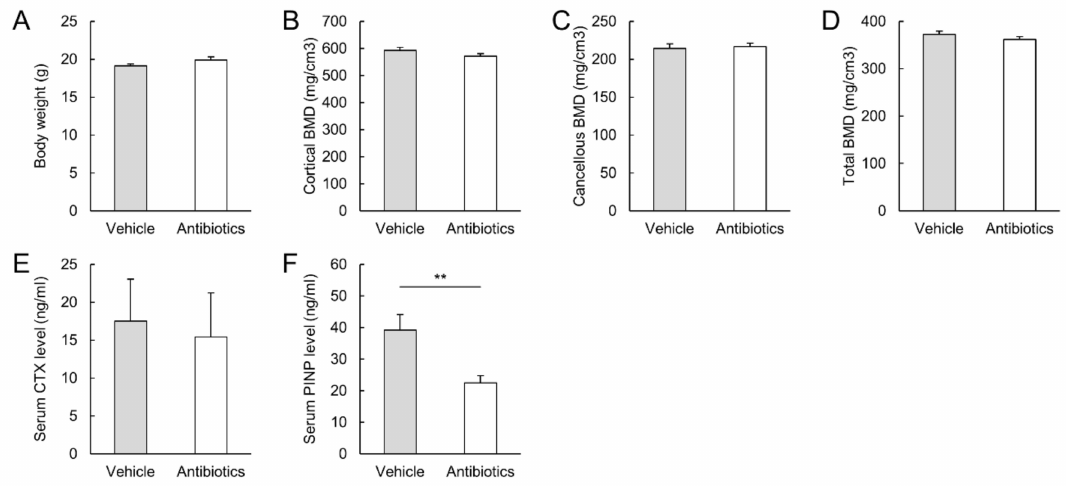
Figure 3. Effect of antibiotics mixture on bone homeostasis. Mice were orally administered antibiotics or vehicle for four weeks. ( A – F ): Body weight, tibial bone mineral density ( B – D ), serum bone formation marker ( E ), and serum bone resorption marker ( F ) at sacrifice. N = 7–10 per group. BMD: bone mineral density, CTX: C -terminal telopeptide of collagen, PINP: procollagen type I N -terminal propeptide. ** p <